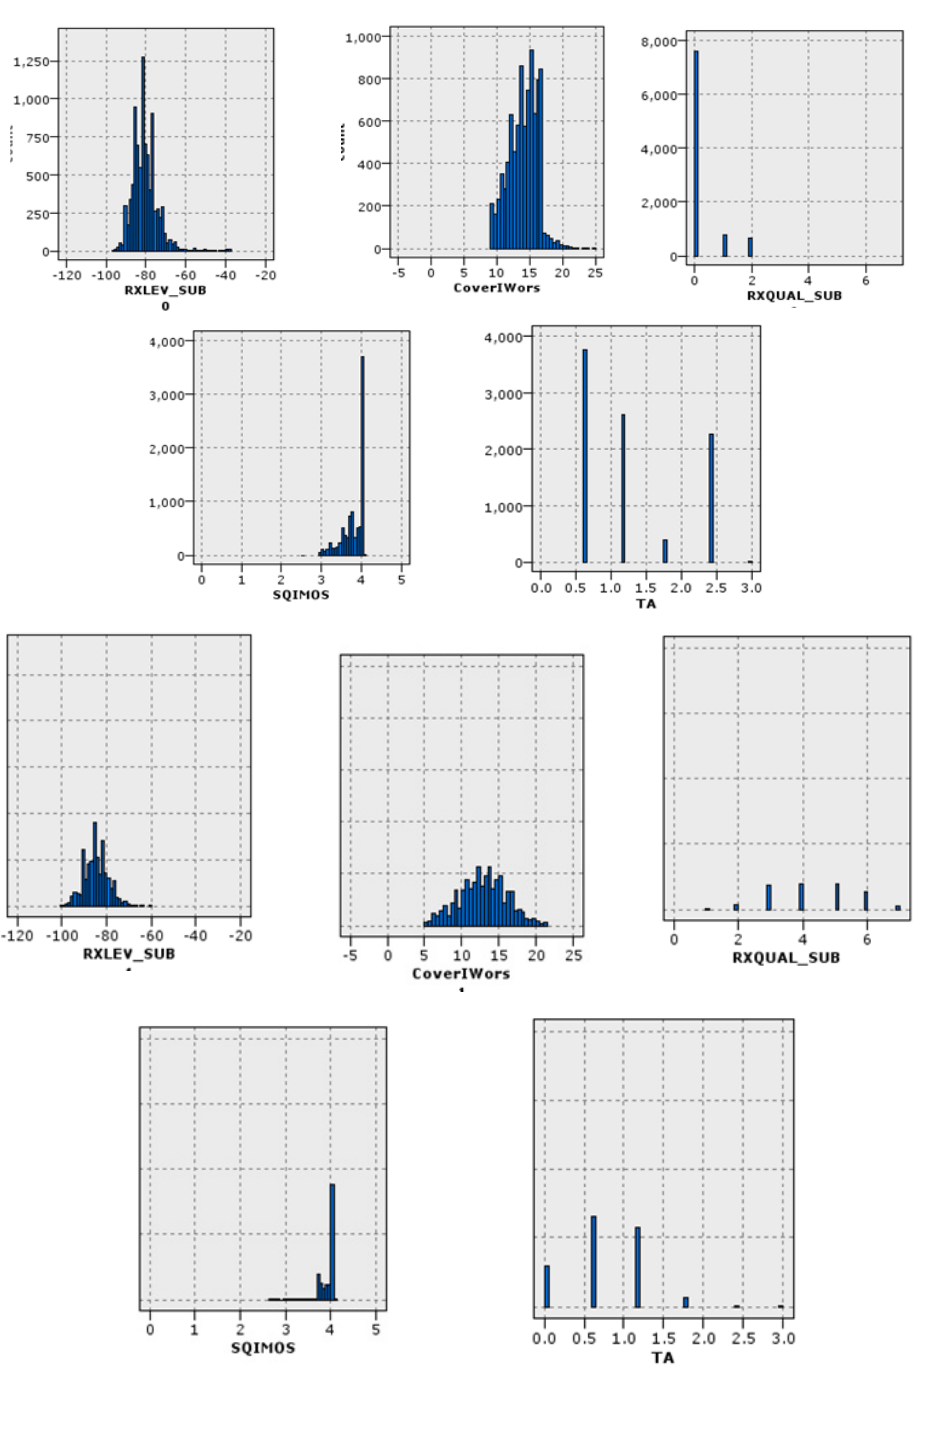
Table 7. The histogram of different features in the obtained clusters–long call. Table 7. the histogram of different features in the obtained clusters–long